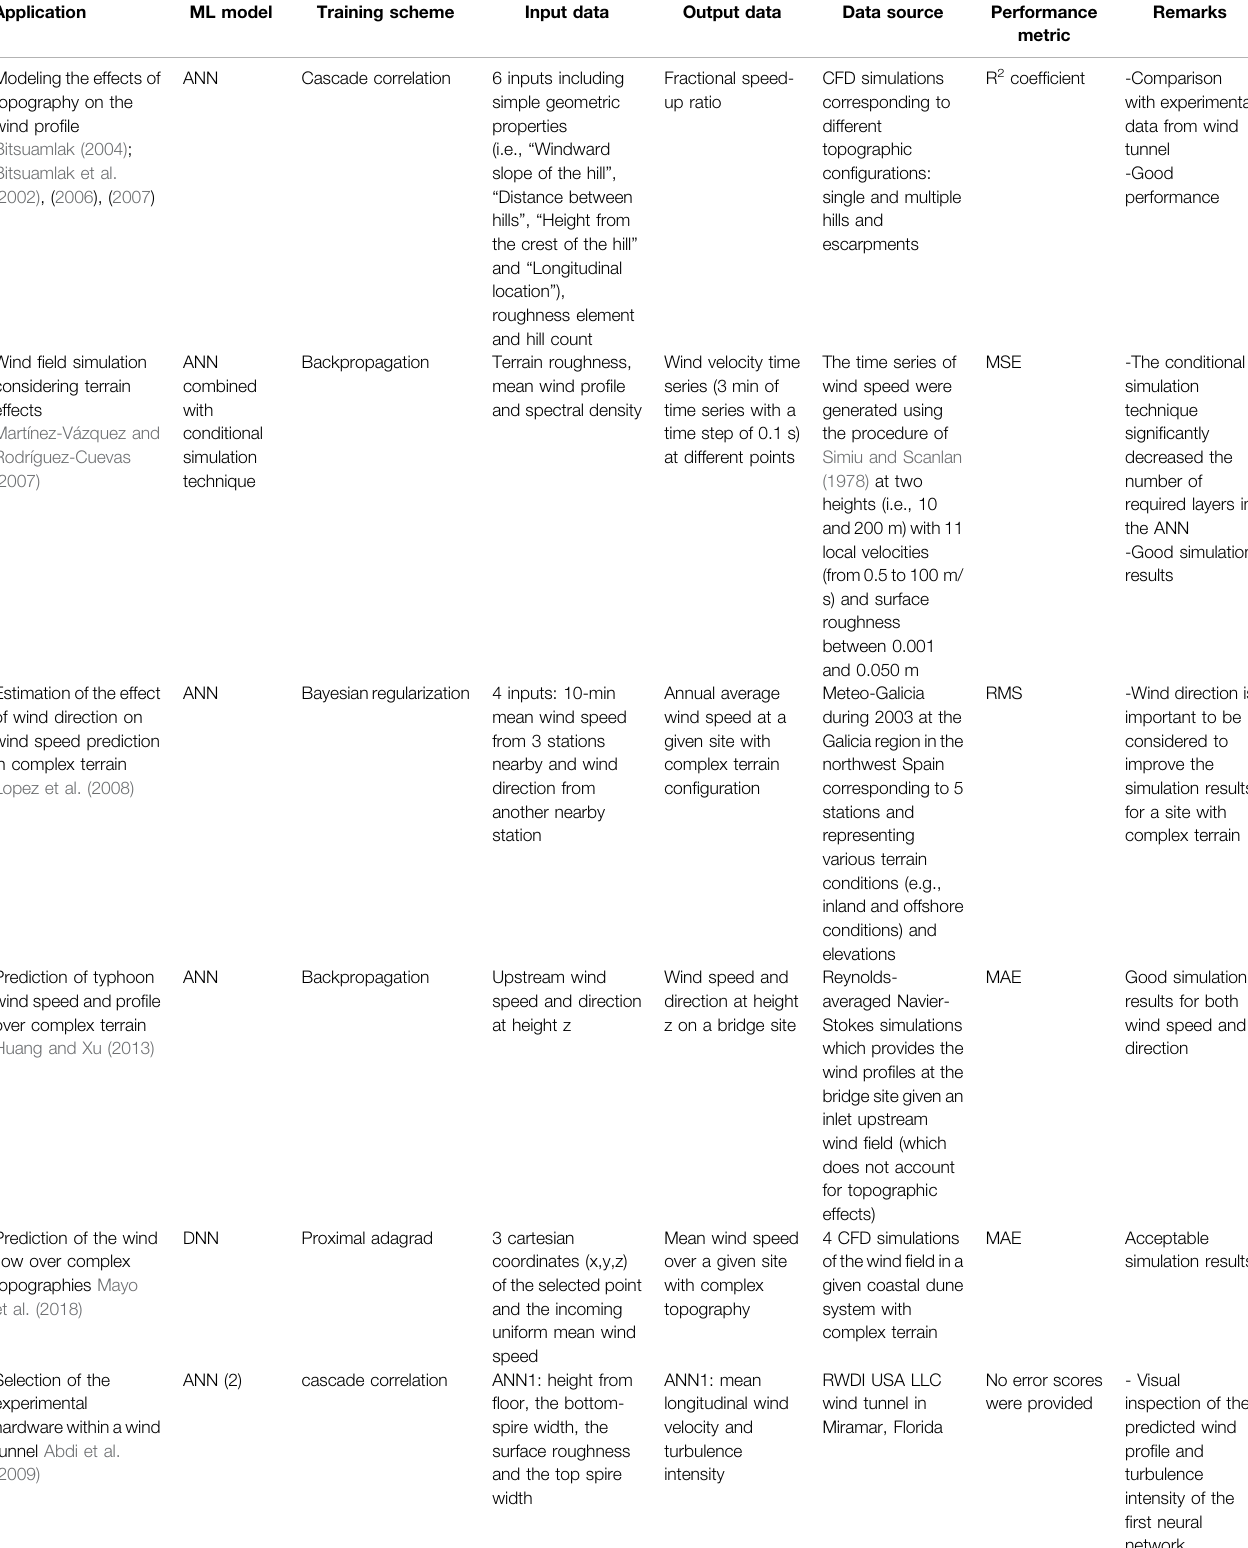
TABLE 4 | Summary of ML applications for terrain and